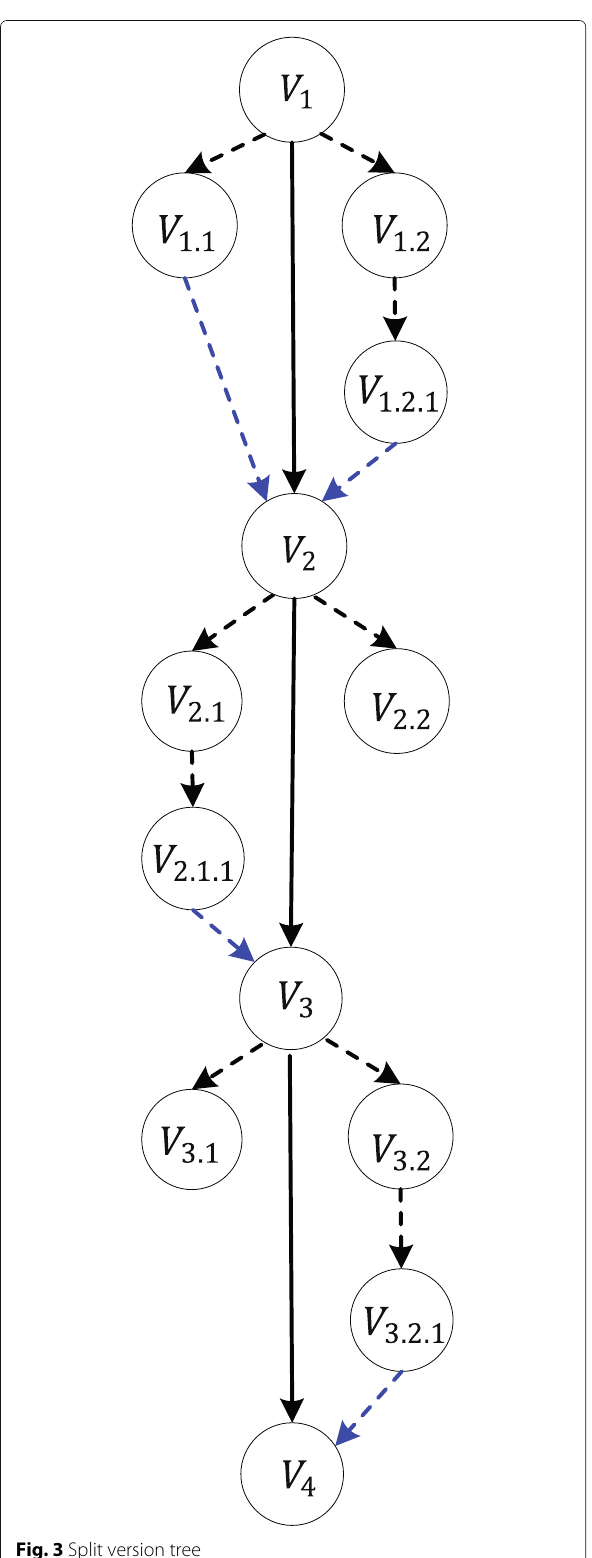
Fig. 3 Split version